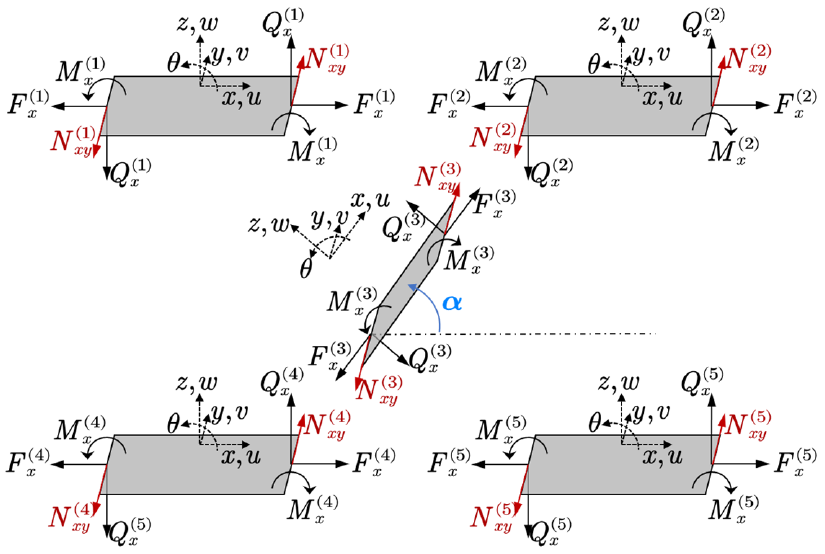
Figure 5. The demonstration of displacement compatibility conditions and force equilibrium conditions. As for the acoustic cavity, the governing equation of the sound pressure inside is the Helmholtz equation [24]: